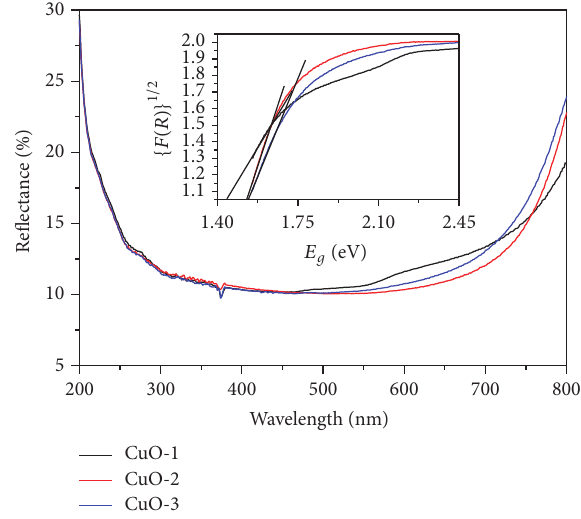
Figure 3: Reflectance spectra of samples CuO-1, CuO-2, and CuO-3 prepared by using extracts of Cauliflower, Potatoes peels, and Peas peels wastes, respectively; the graph in inset shows the modified Kubelka-Munk curves drawn by plotting {𝐹(𝑅)} 1/2 versus 𝐸 𝑔 .